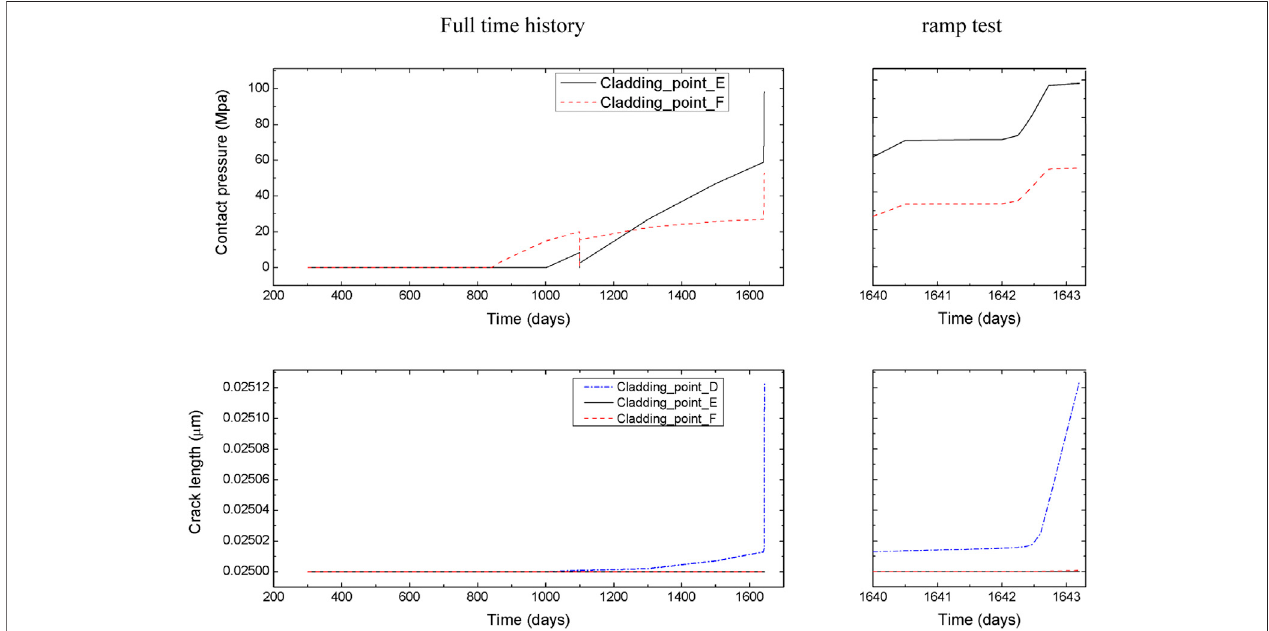
FIGURE 17 | Contact pressure and crack length distribution in full irradiation history at pre-set points.